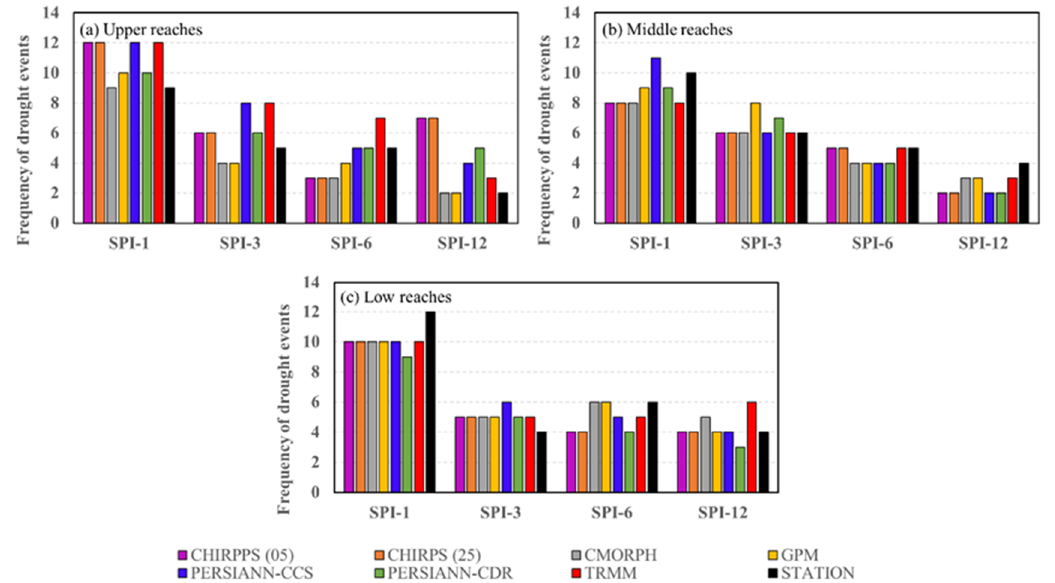
Figure 7. Drought event frequencies given by SPPs and observations.